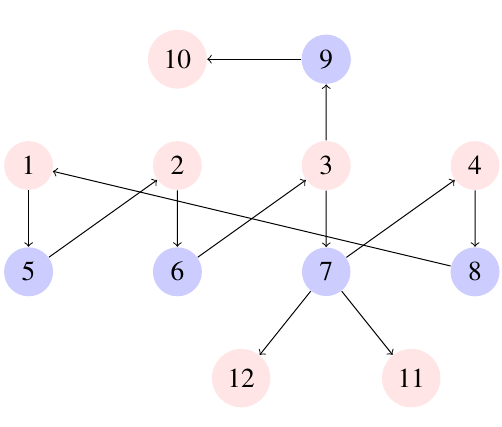
Fig. 7. An example pf G 2 CBR